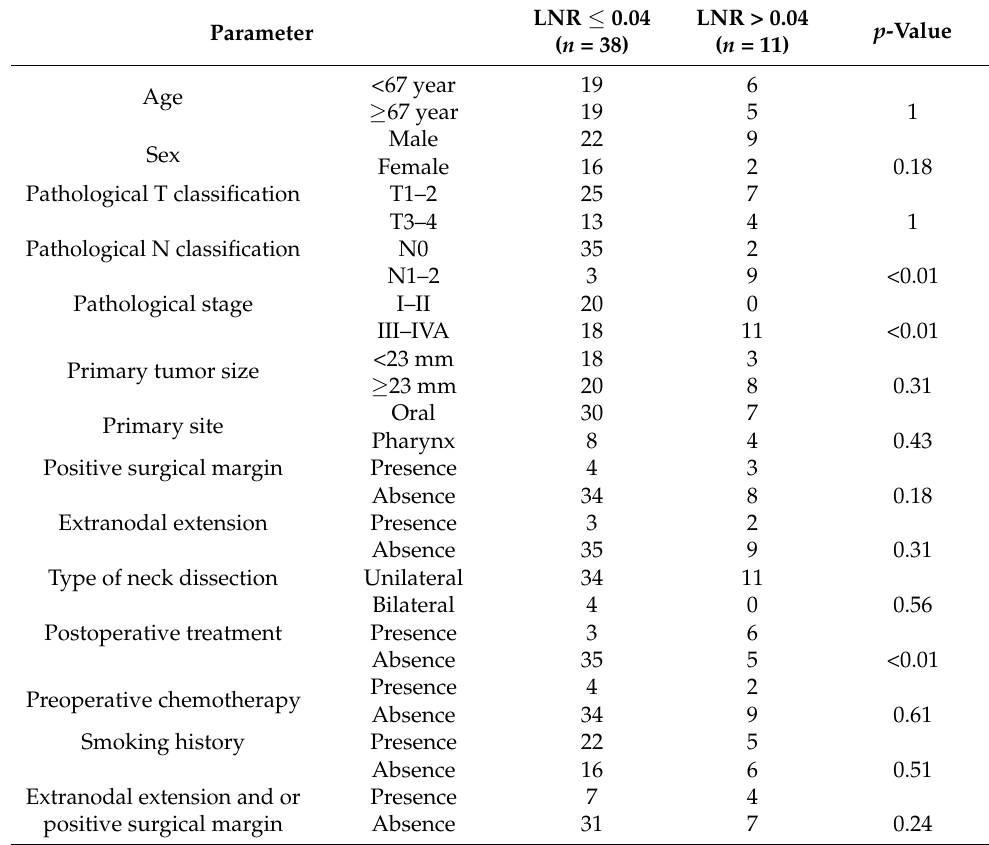
Table 2. Association between clinicopathologic parameters and LNR by Fisher’s exact test.